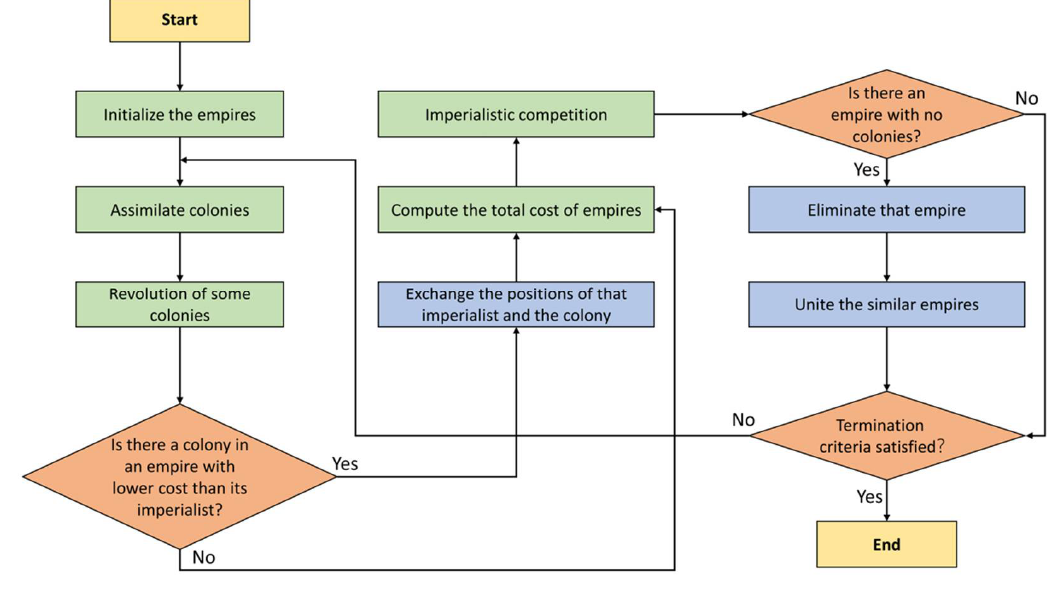
Figure 3. ICA algorithm to optimize problems.